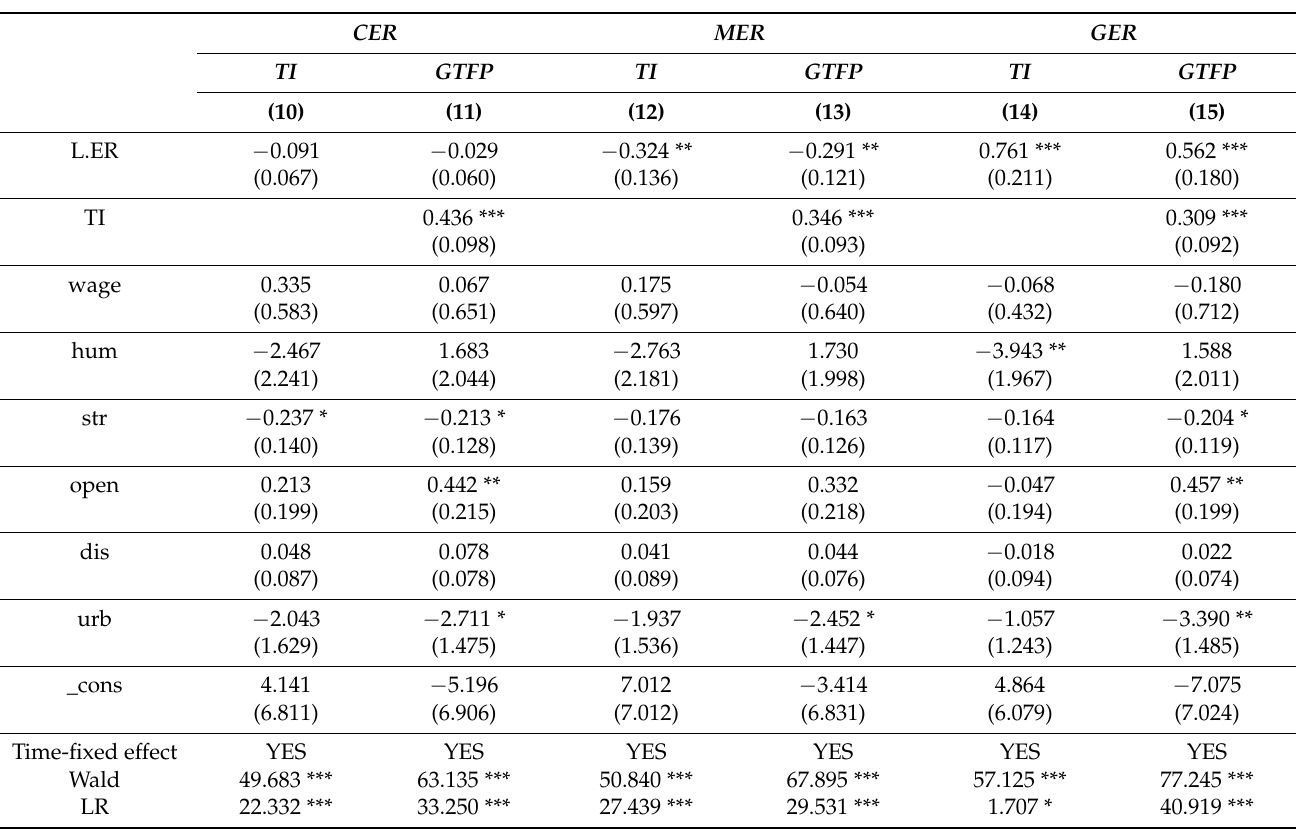
Table 5. Intermediary effect of technological